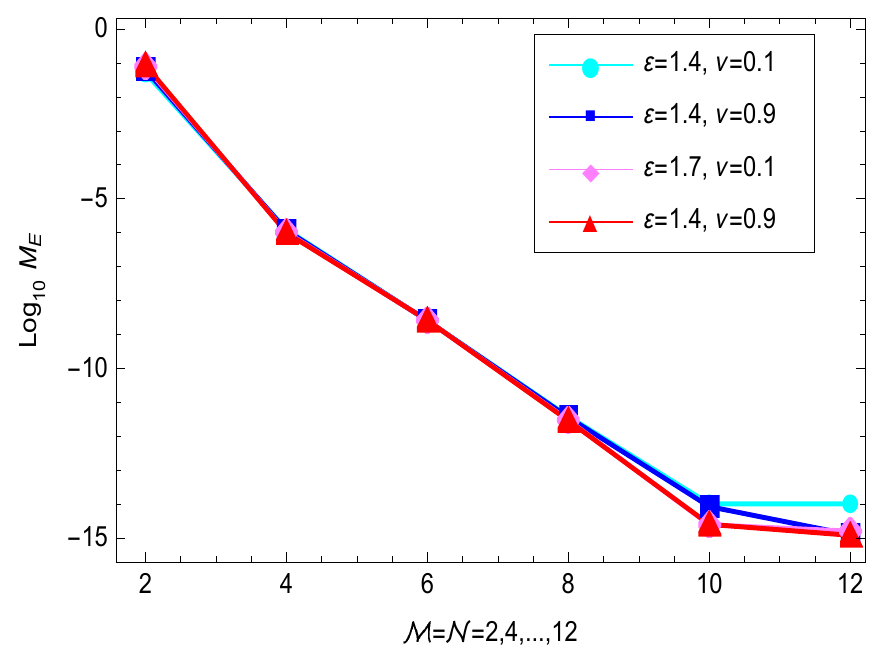
Figure 6. M E convergence of problem (17), for different values of ε and ν .